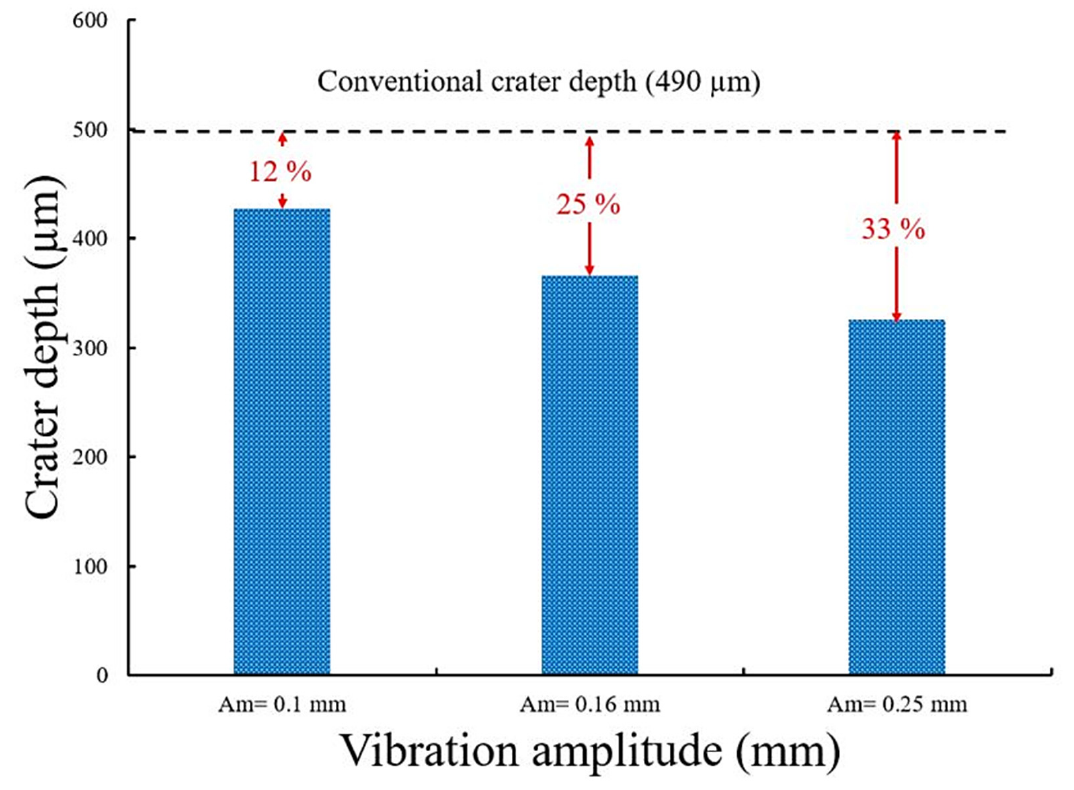
Figure 13. The measured crater depth at different vibration amplitude for N = 3000 rpm.